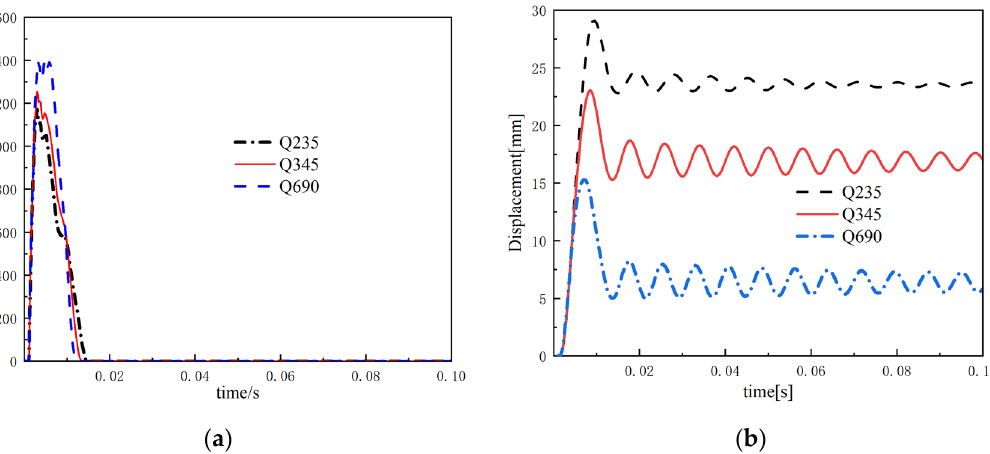
Figure 14. Different steel tube strength. ( a ) Impact-time history curve. ( b ) Displacement-time history curve.